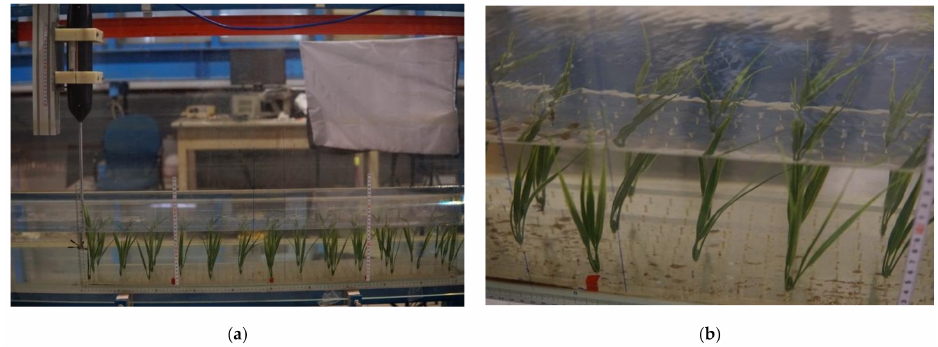
Figure 4. Test run S9 with grasses. ( a ) The average flow velocity is 0. ( b ) The average flow velocity is 0.23